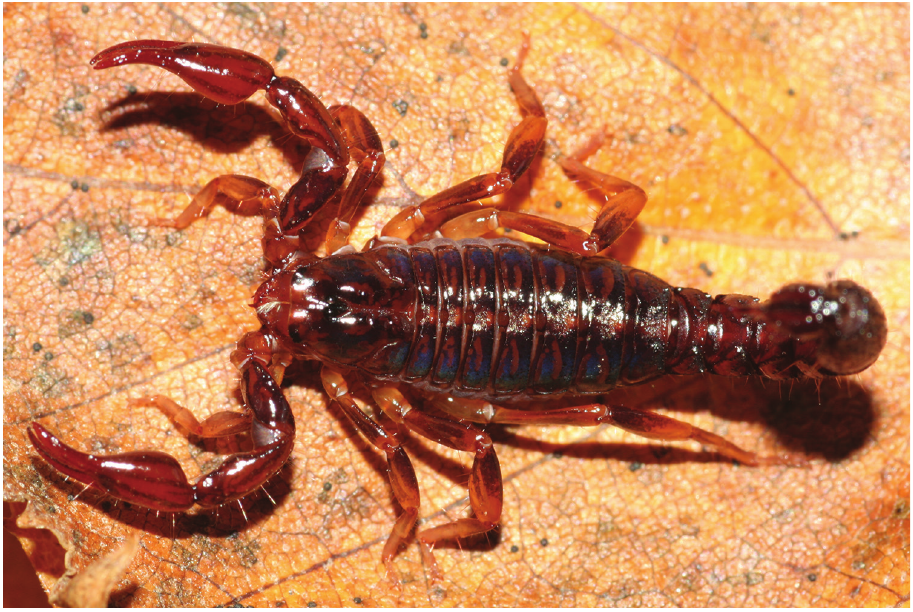
Figure 29. Hadrurochactas schaumii , male from Cacao. and shiny in female; spiracles small and semi-oval in shape. Metasomal segments very strong in relation to the body; carinae only on dorsal and latero-dorsal sides; ventral side of metasomal segment I-IV in female and I-III in male smooth, the IV with fine granulation in male; segment V with ventral and lateral sides smooth in female and with granules in male. Telson smooth dorsally, granular with spinoid granules on lateral and ventral sides; aculeus weakly curved with a spinoid subaculear tooth. Pedipalp femur smooth in female and with granules on lateral sides in male, with five carinae; patella smooth and shiny, with three carinae; chela smooth and shiny, without granules and carinae; fingers about the same length as chela; fixed and movable fingers with seven rows of linear granules. Legs smooth, without granules and